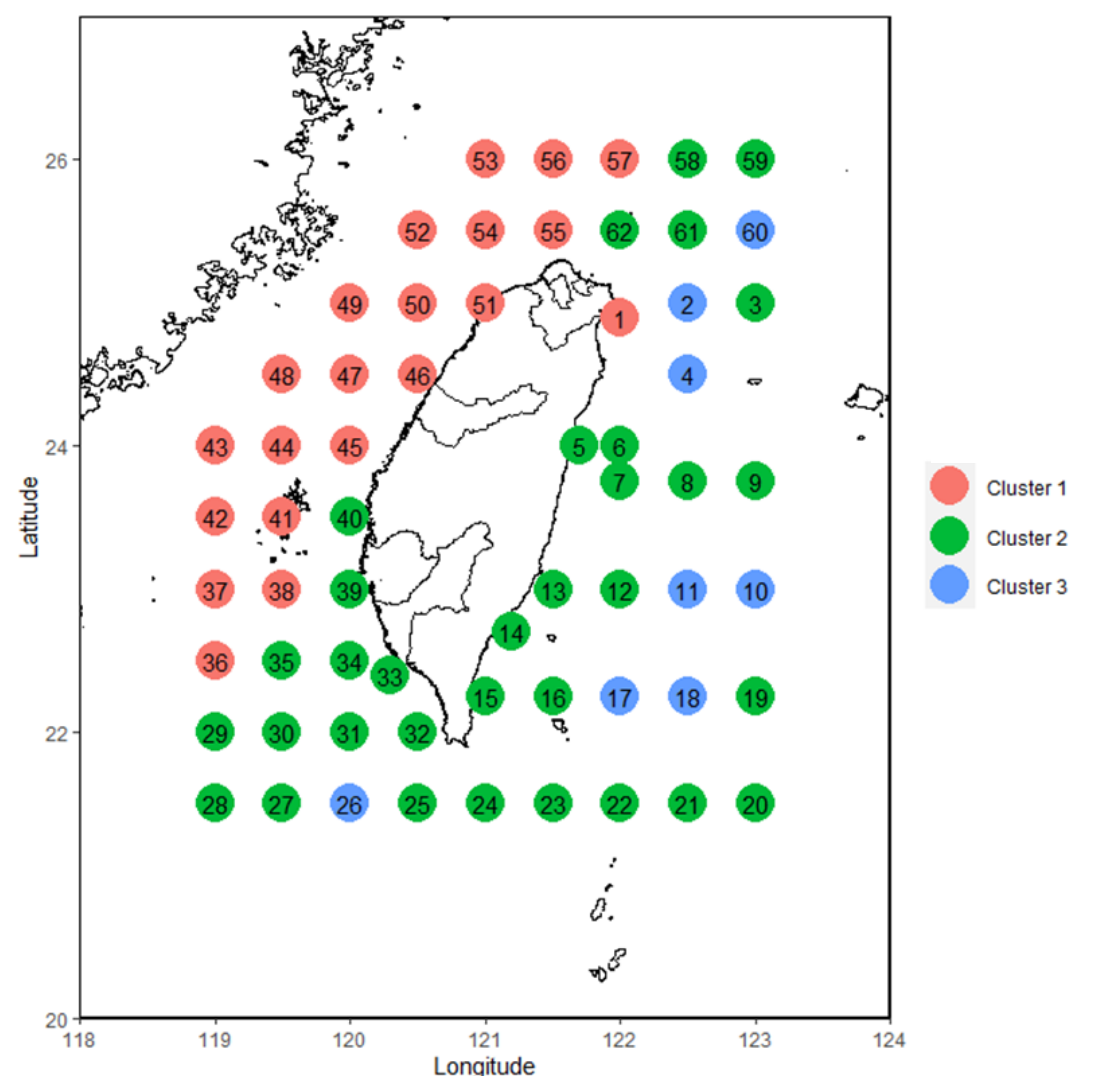
Figure 7. Geographic distribution of the cluster analysis results of fish larvae and juveniles collected around Taiwan from 2007 to 2019 overlaid on a map.